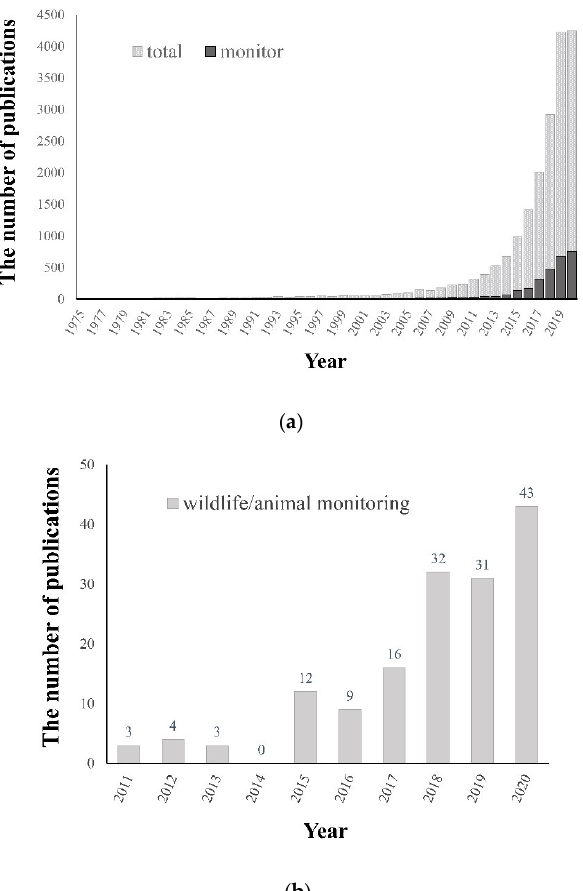
Figure 1. The number of publications related to remotely piloted aircraft systems (RPAS) and animal monitoring. ( a ) Web of Science search for articles containing topics “unmanned aerial” or “unmanned aircraft” or “remotely piloted aerial” or “remotely piloted aircraft” or “drone” but not “honey bee”, yielding 19,399 publications, refined with “monitoring”, obtaining 2807, from 1975 until November 2020. ( b ) The number of studies using RPAS for animal monitoring during the last ten years.